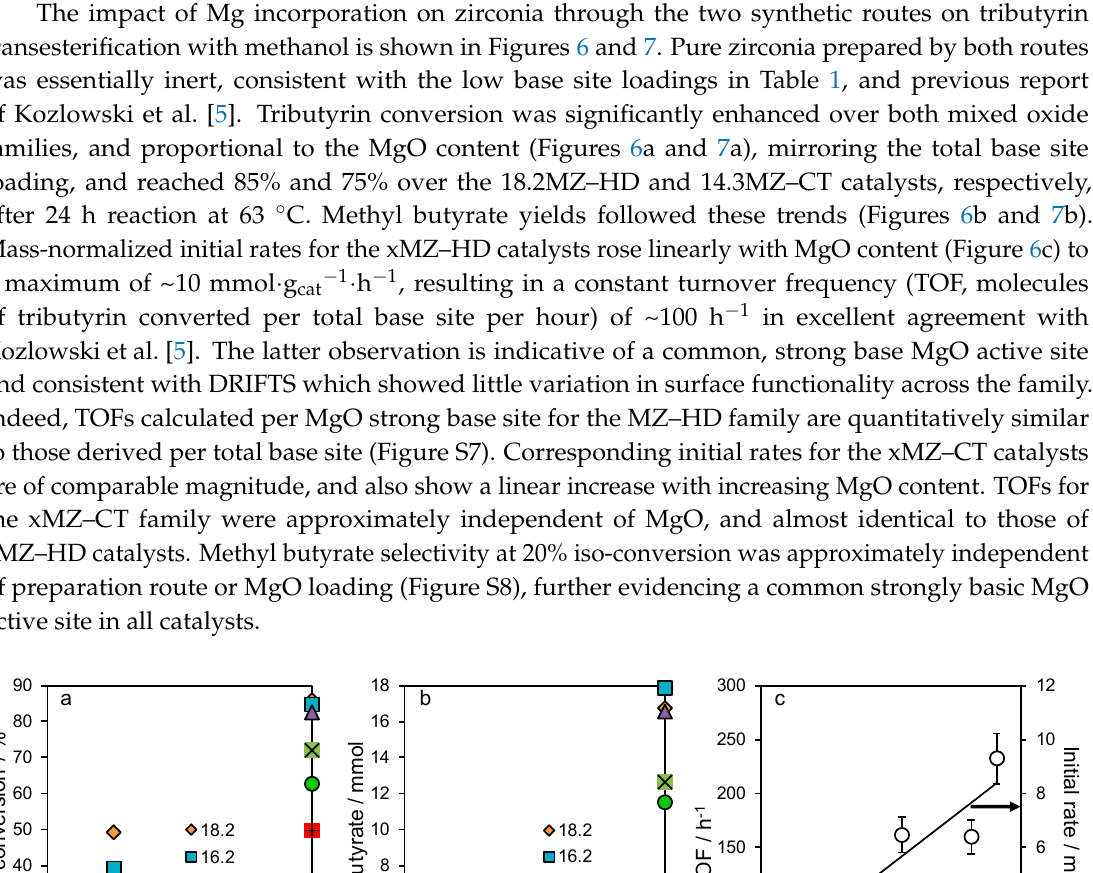
Figure 5. CO 2 -temperature-programmed desorption (TPD) profiles of: ( a ) xMZ–HD; and ( b ) xMZ– CT mixed oxides.